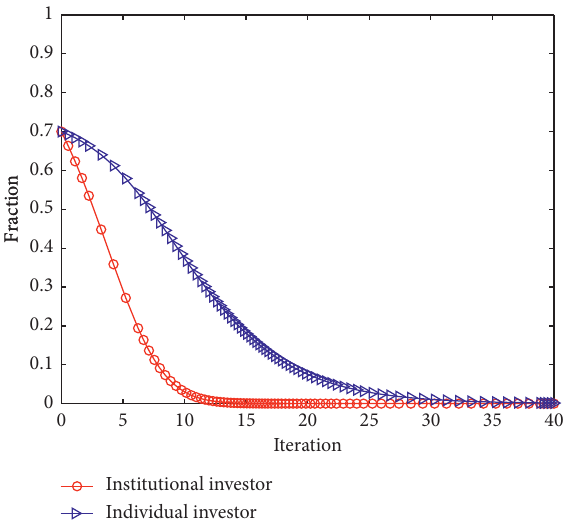
Figure 1: Simulation results for institutional investors and indi- vidual investors using the parameters R M � 2, C M � 1, R � 1, β � 0, and δ � 0 . 3. R 1